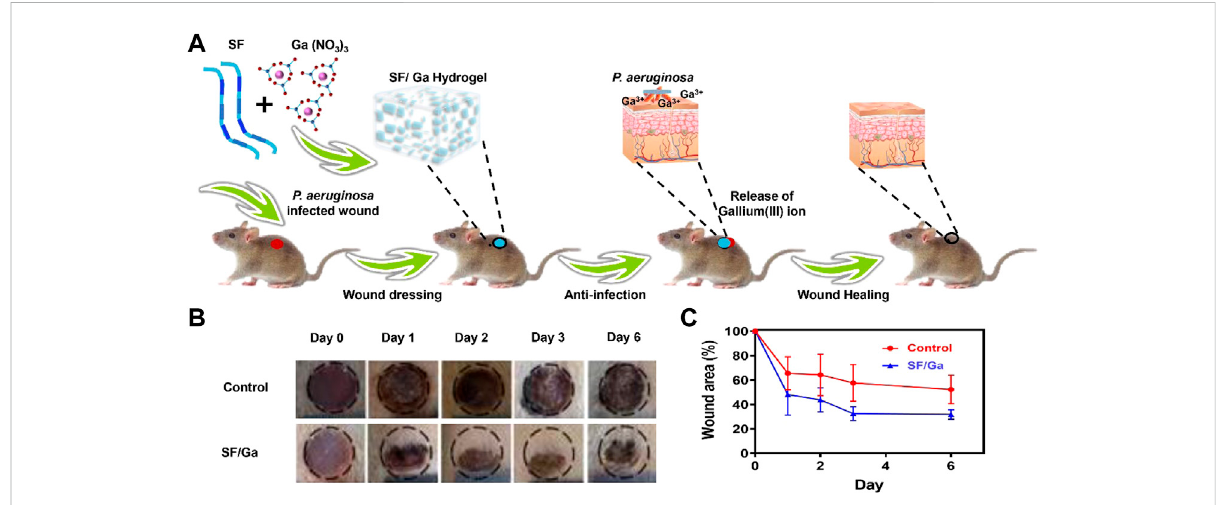
FIGURE 6 In vivo antibacterial activity of SF/Ga hydrogel. (A) Schematic illustration of SF/Ga hydrogel promotion of healing of a P aeruginosa -infected wound, (B) Digitalimagesof P.aeruginosa infectedwoundcoveredwithPBS,andSF/Gahydrogel (C) Quantitativecurveofwoundareafortreatment groups, PBS and SF/Ga hydrogel (mean ± SD, n =